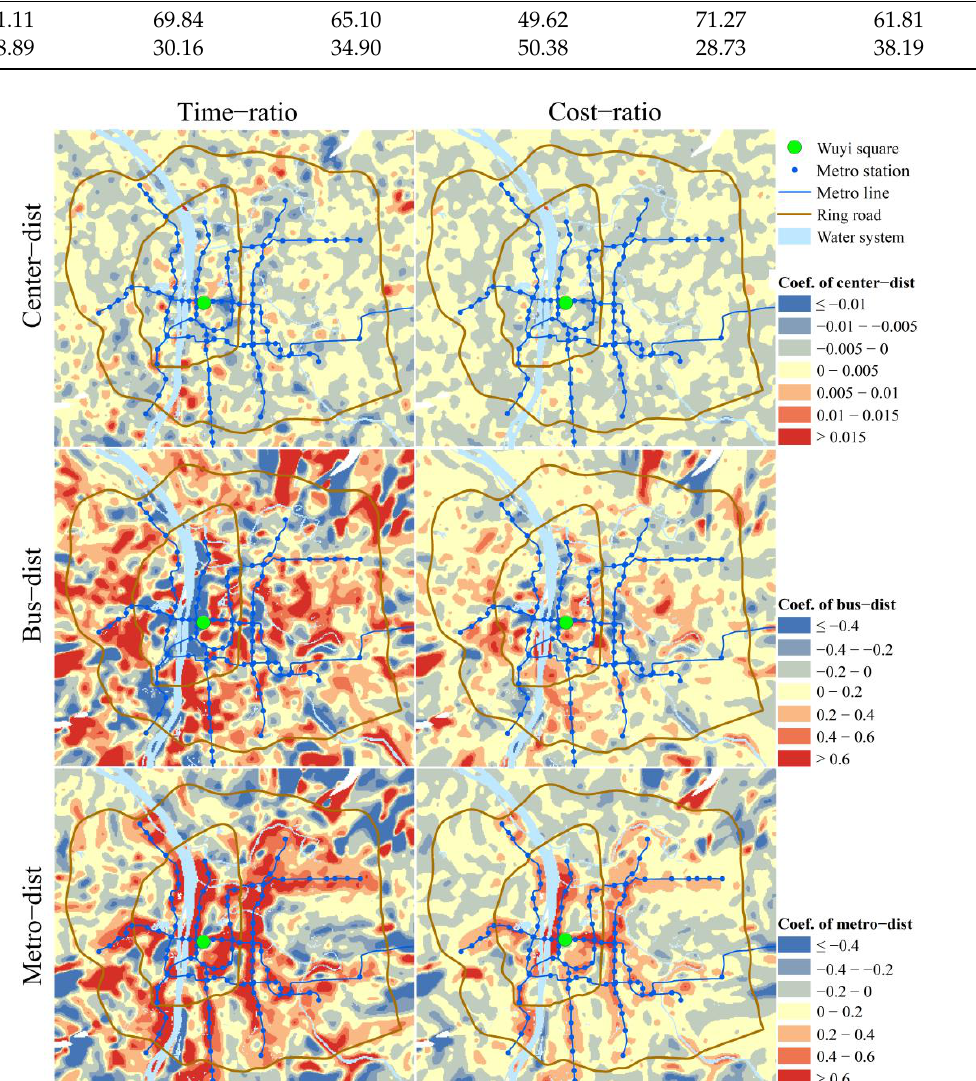
Figure 9. Spatial distribution of the regression coefficients for each explanatory variable.